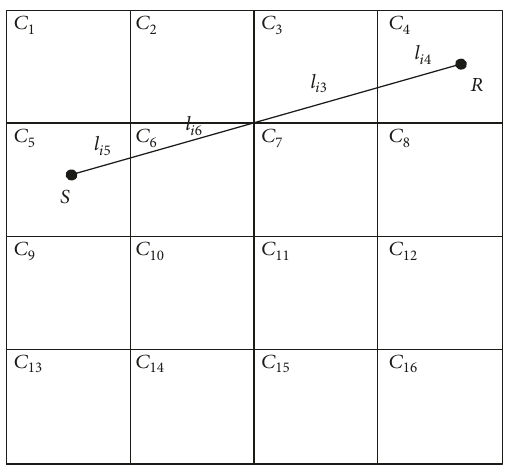
Figure 3: Schematic diagram of the chromatography. The link passes through the grid at 𝐶 5 , 𝐶 6 , 𝐶 3 , and 𝐶 4 , and their lengths in the grid are denoted as 𝑙 𝑖5 , 𝑙 𝑖6 , 𝑙 𝑖3 , and 𝑙 𝑖4 ,